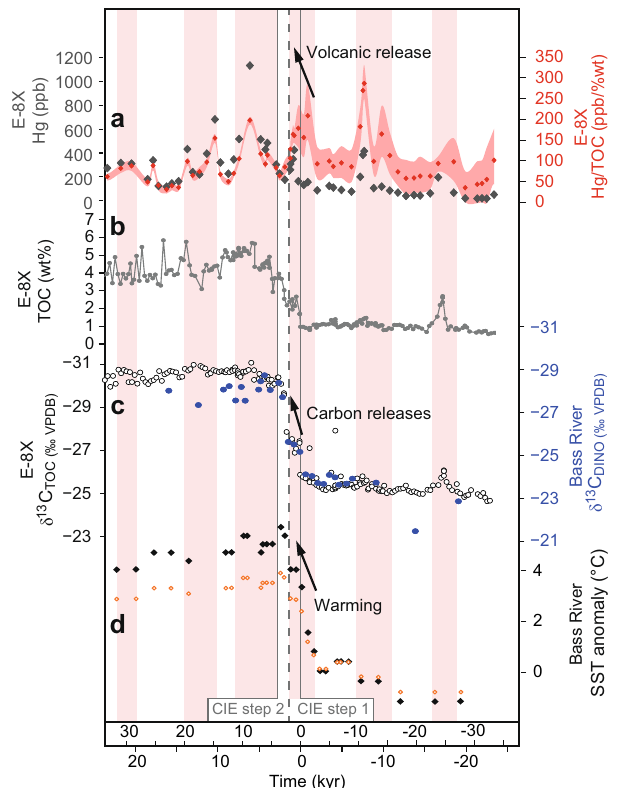
Fig. 6 Proxies for volcanism, carbon release and temperature in the time domain; thousands of years from the start of the PETM carbon isotope excursion (CIE). a Sedimentary mercury (Hg) and Hg/total organic carbon (Hg/TOC) for core E − 8X (this study). Hg/TOC envelope re fl ects an analytical error, illustrating higher uncertainty in samples with lower TOC. b Sedimentary TOC weight (wt) % for core E − 8X (this study). c Sediment proxy records for TOC isotopes ( δ 13 C TOC ) at E − 8X (this study), and carbon isotopes of sedimentary organic-walled dino fl agellate cysts ( δ 13 C DINO ) from Bass River, New Jersey 38 , used to correlate the two sites (Fig. 3). d Sea surface temperature (SST) anomaly proxy data from Bass River, New Jersey 38 . The same data are presented with two different calibrations for temperature in orange 63 and black 64